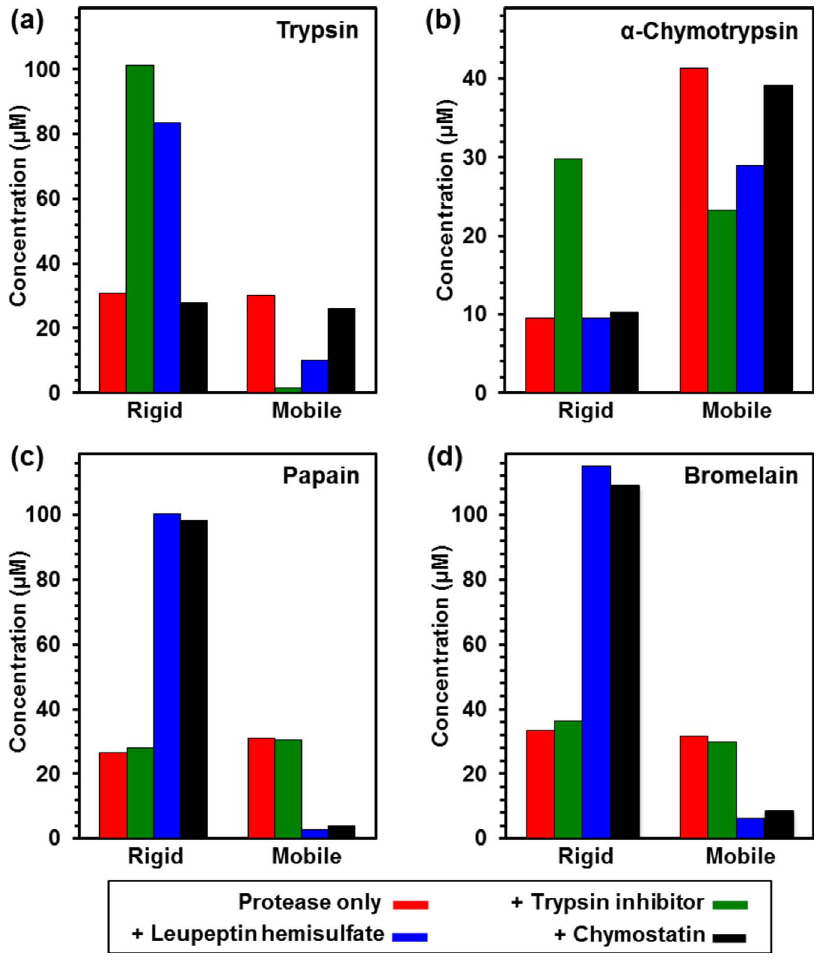
Figure 6. Rigid and mobile population concentrations following a 24-hour, room-temperature digestion of HgA by four proteases: Trypsin, a -chymotrypsin, papain, and bromelain. Each protease acted alone or in the presence of three known protease inhibitors. Total substrate concentration was 100 l